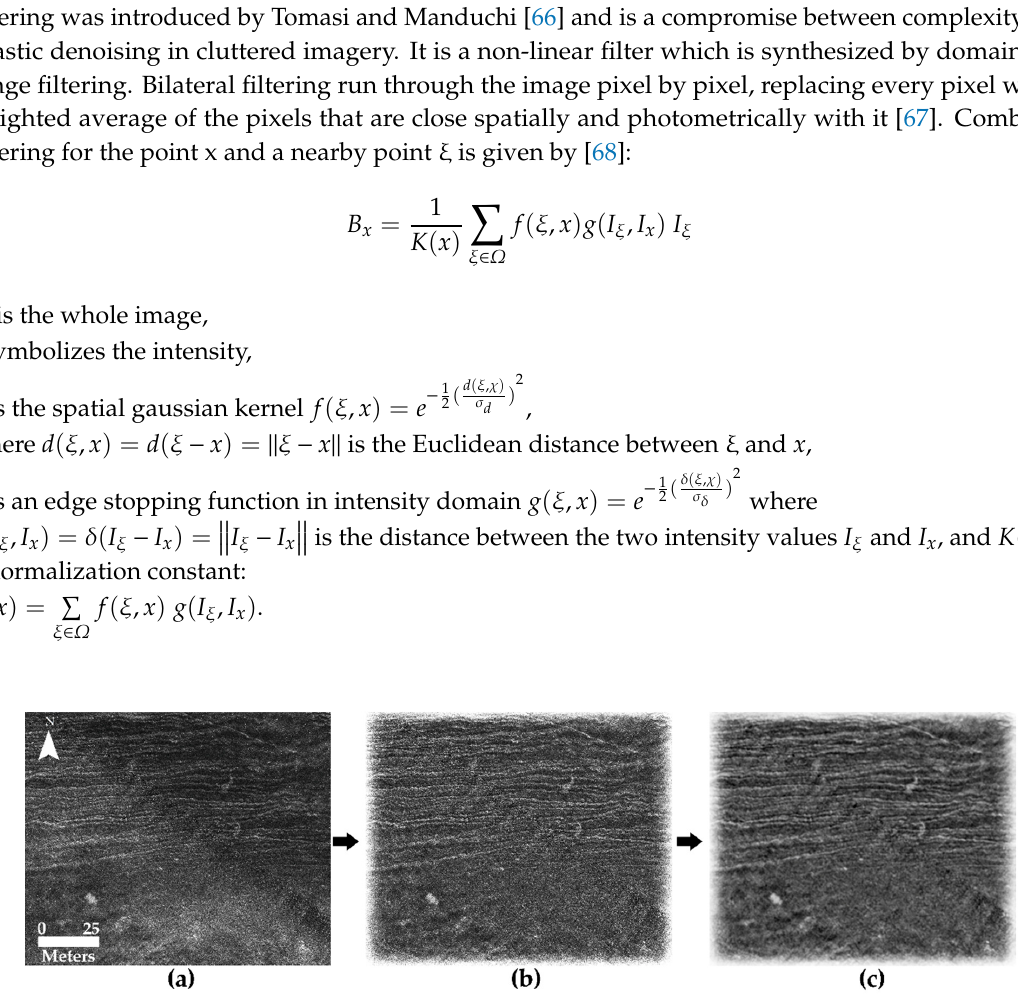
Figure 4. ( a ) The original SSS image, ( b ) the SSS image after application of Homomorphic filter and ( c ) after edge preserving